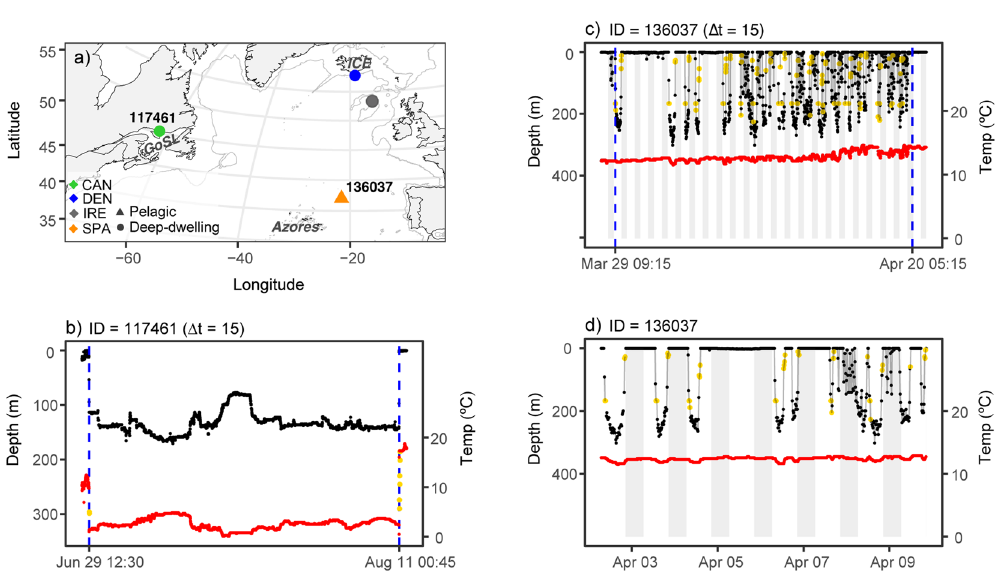
Figure 3. Predation by ectothermic fish. ( a ) Pop-up locations of the tags consumed by ectothermic fish, coded by predator type and origin. Grey lines indicate the 1000 m bathymetry contour. GoSL = Gulf of St. Lawrence and ICE = Iceland. ( b ) Depth (black) and temperature (red) profiles for a tag consumed by a deep-dwelling ectothermic fish in the Gulf of St. Lawrence. ( c , d ) Recorded depths (black) and temperatures (red) for a tag consumed by a pelagic ectothermic fish north of the Azores. Yellow points indicate values distorted by the tag, blue vertical lines indicate the time of ingestion and expulsion, and grey areas indicate night. Tag ID and temporal resolution of the tag data ( Δ t) are stated above panel b and c, and the corresponding Tag IDs are also indicated in panel